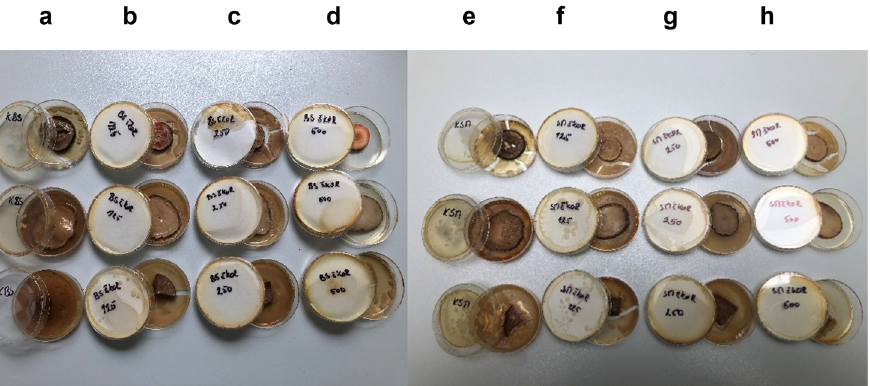
Figure 3: In situ antimicrobial activity ofCCEO onvegetables invapour phase. ( a ) controlsampleofcarrot, potato, and apple contaminatedwith B. subtilis ; ( b ) e ff ect of CCEO at 125µL/plate on carrot, potato, and apple contaminated with B. subtilis ; ( c ) e ff ect of CCEO at 125µL/plate on carrot, potato, and apple contaminated with B. subtilis ; ( d ) e ff ect of CCEO at 125µL/plate on carrot, potato, and apple contaminated with B. subtilis ; ( e ) control sample of carrot, potato, and apple contaminated with S. maltophilia ; ( f ) e ff ect of CCEO at 125µL/plate on carrot, potato, and apple contaminated with S. maltophilia ; ( g ) e ff ect of CCEO at 250 µL/plate on carrot, potato, and apple contaminated with S. maltophilia ; ( h ) e ff ect of CCEO at 500 µL/plate on carrot, potato, and apple contaminated with S. maltophilia